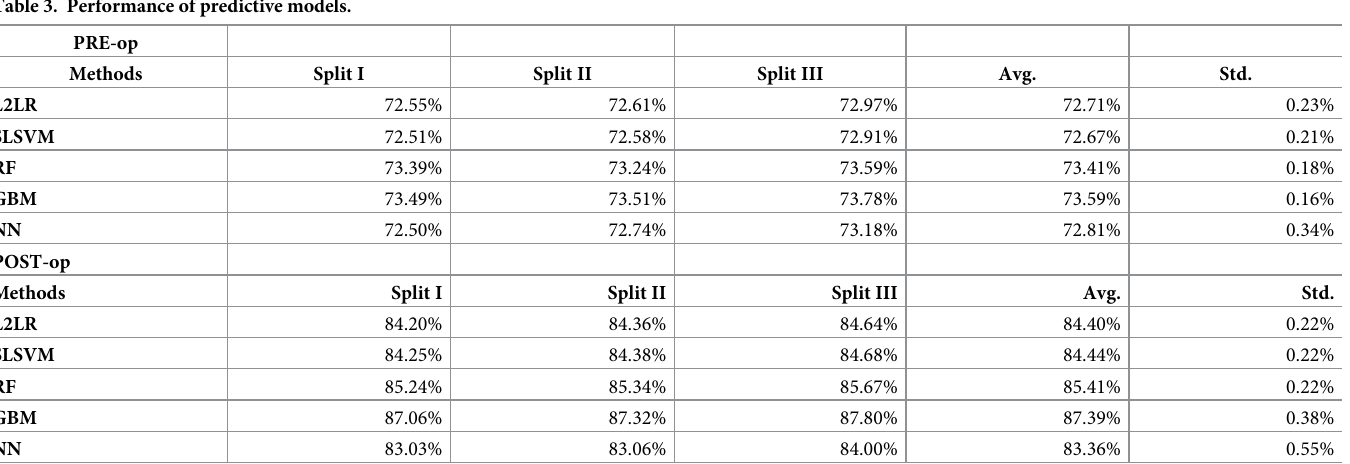
Table 3. Performance of predictive